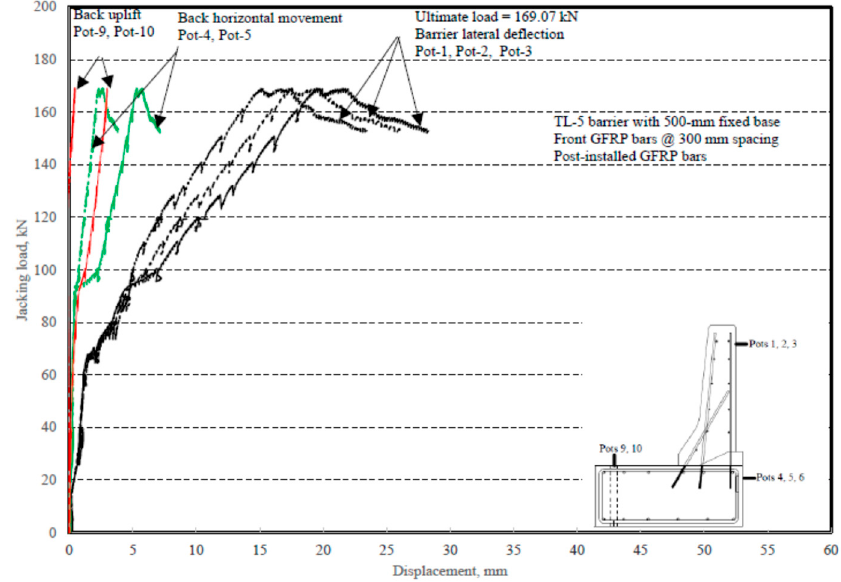
Figure 27. Specimen # 5: Load vs. displacement history.